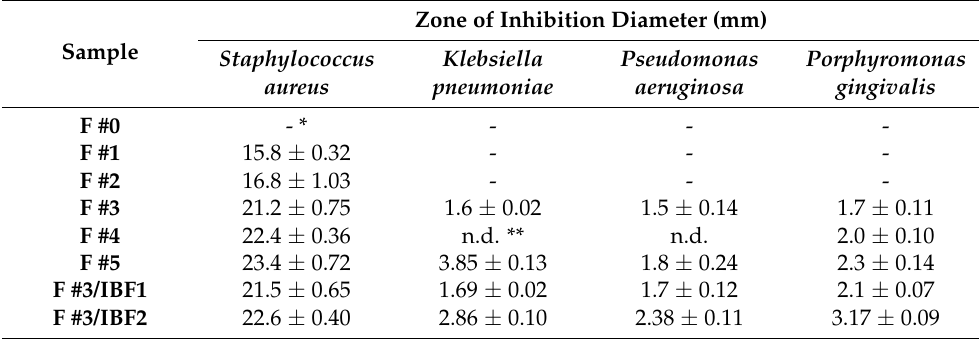
Table 3. Inhibition zone diameters of the composite PVA/OxCS-Ag and ibuprofen-loaded PVA/OxCS-Ag films against different microorganisms. Zone of Inhibition Diameter (mm) Sample Staphylococcus Klebsiella Pseudomonas Porphyromonas aureus pneumoniae aeruginosa gingivalis F #0 -